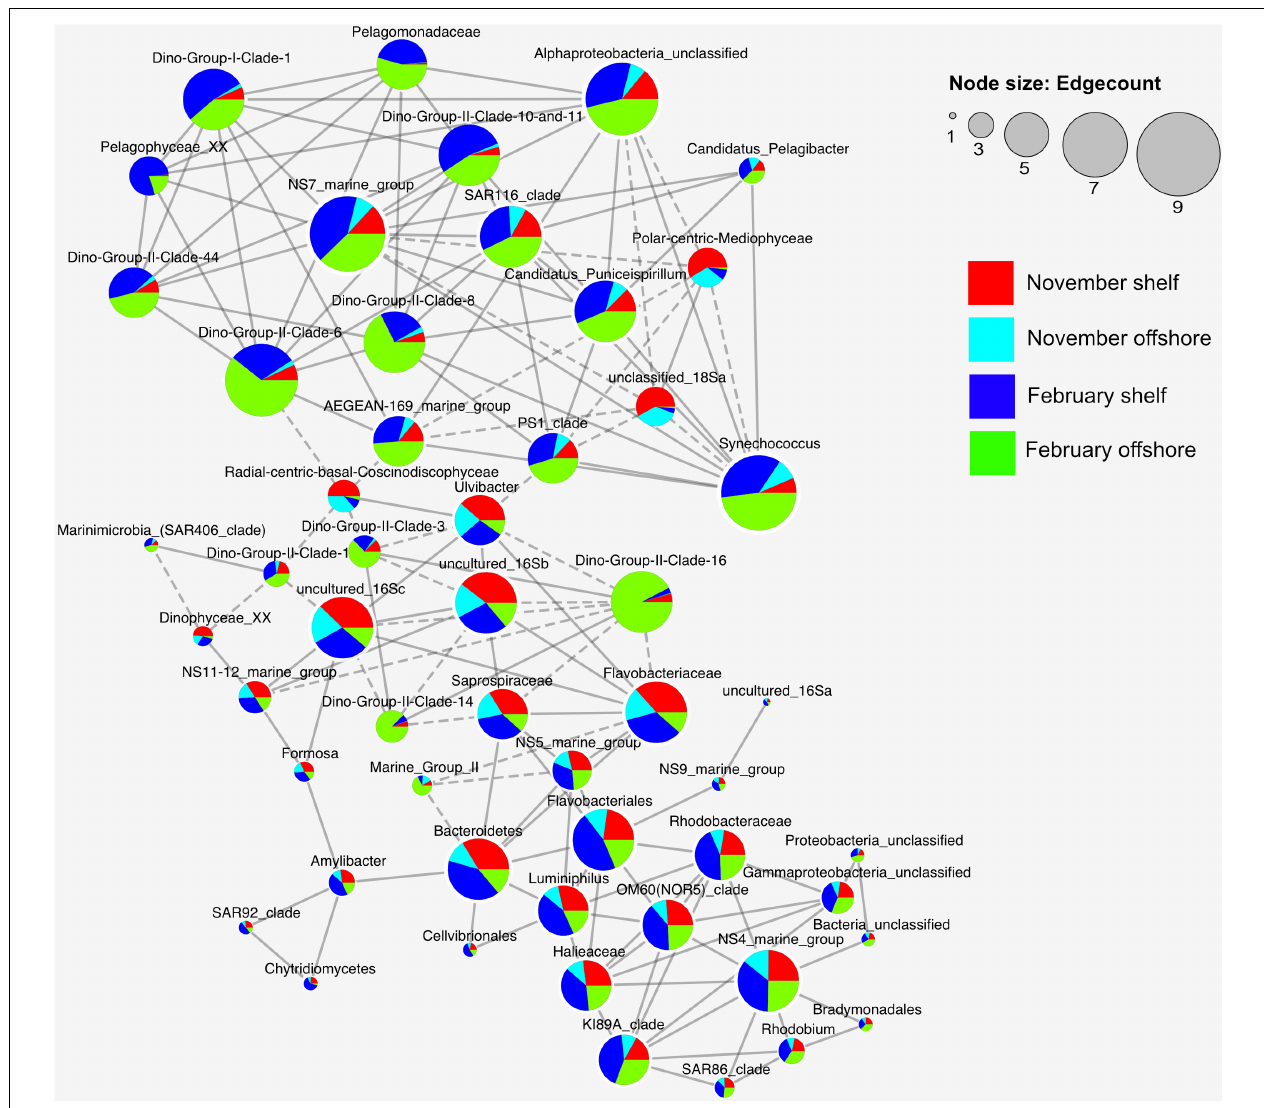
FIGURE 6 | Co-occurrence network analysis for the top 37 bacterioplankton and picoeukaryote families present in the November 2015 and February 2016 samples. Only the Spearman rank correlations that were statistically significant ( P < 0.01) and strong ( r > 0.8) are shown. Edges with dashed lines represent negative associations ( r -values), and nodes are sized relative to how many edges are connected to each